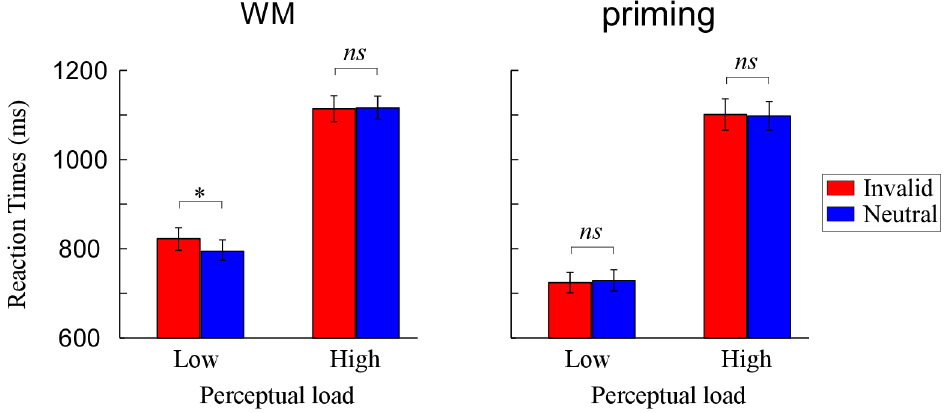
Fig 2. Mean reaction times (RTs) as a function of perceptual load and validity when the cue was held in WM and when it was merely identified. * p < .05, ** p < .01, *** p <